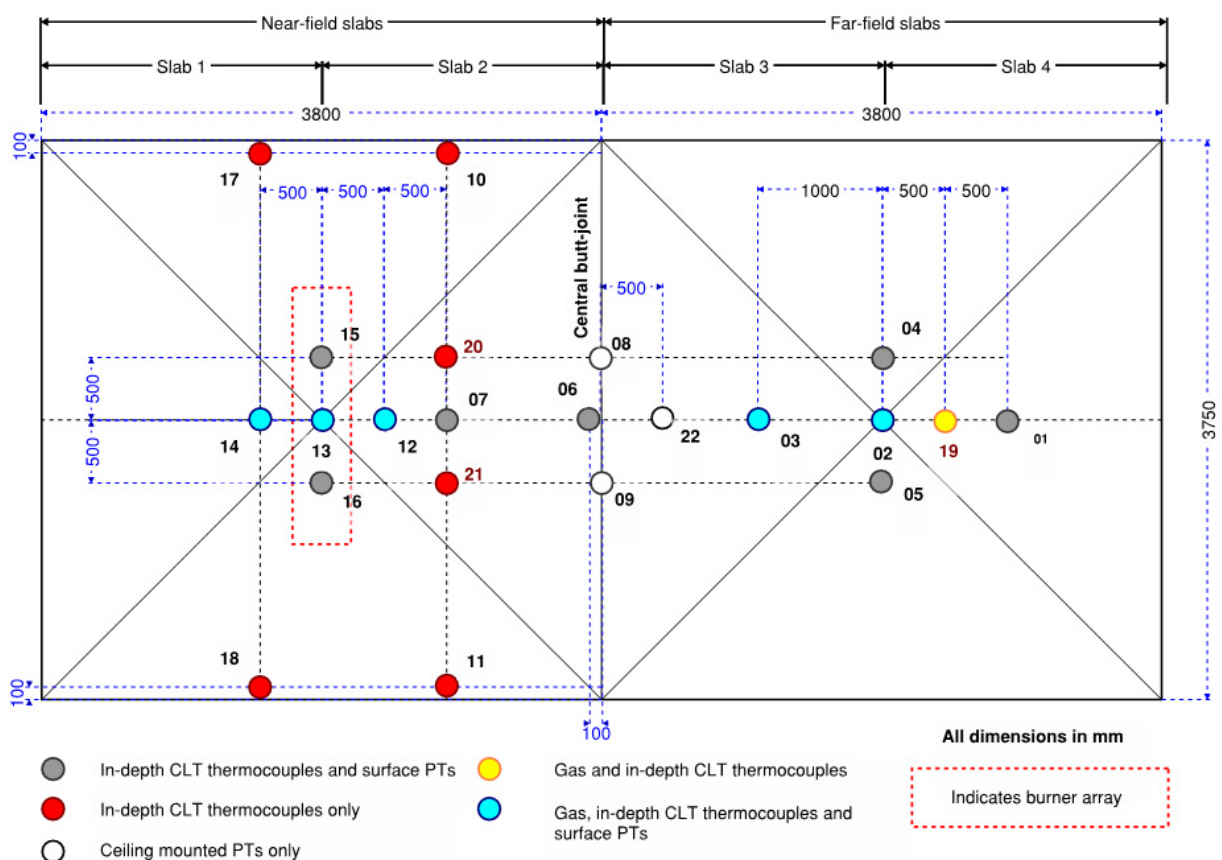
Figure 5. Enclosure plan showing key enclosure dimensions, measurement locations and references, slab locations and burner array position.